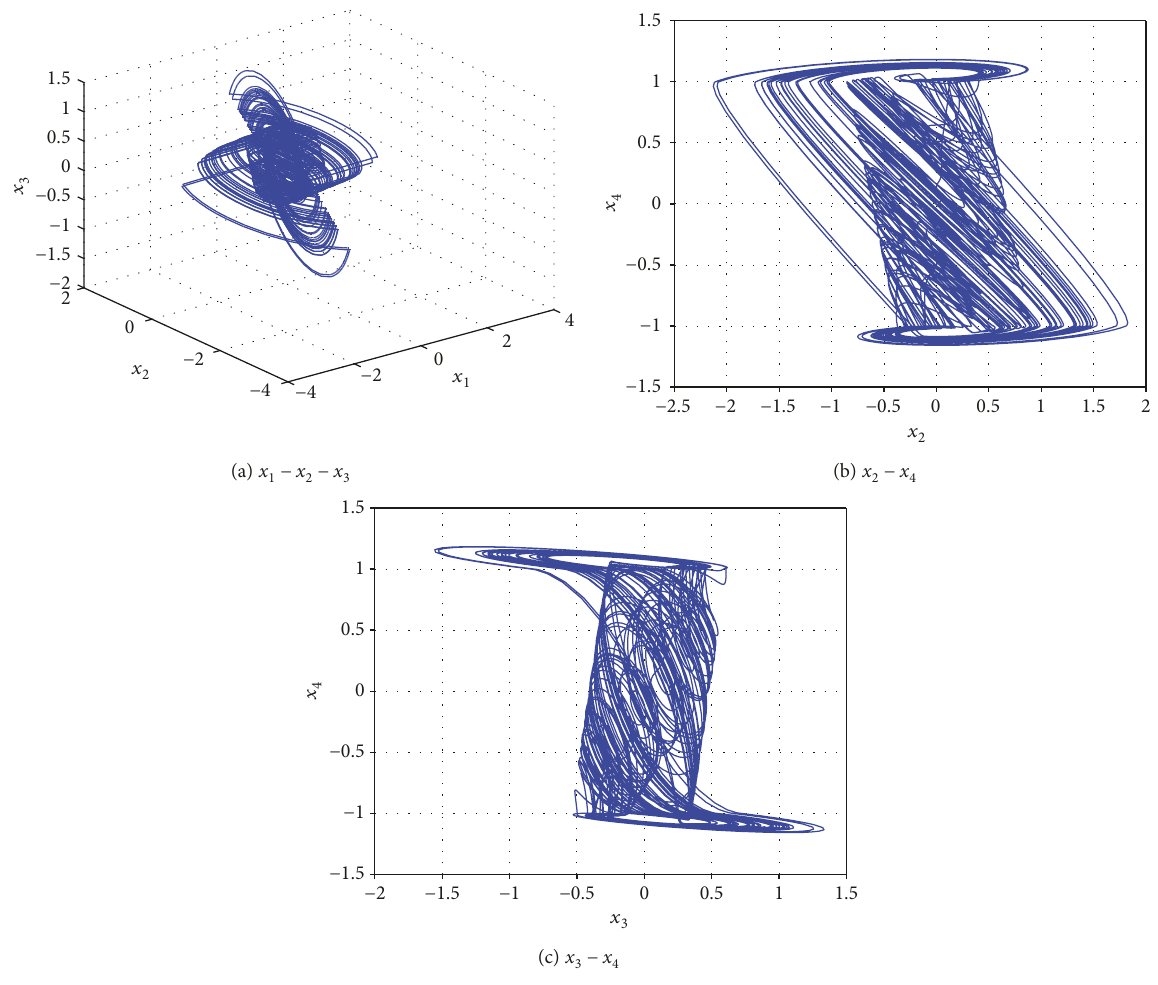
Figure 1: Memristive Chua